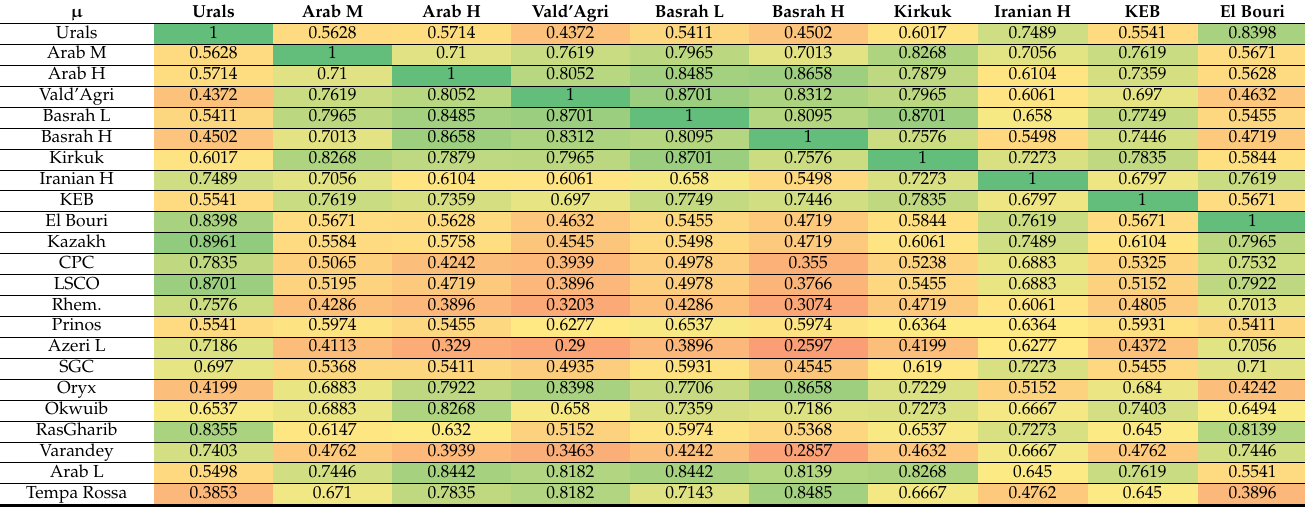
Note: Green color denotes statistically meaningful positive relation; red color denotes statistically meaningful negative relation. The intensity of the color designates the strength of the relation. The higher the color intensity, the higher the strength of the relation. Yellow color denotes